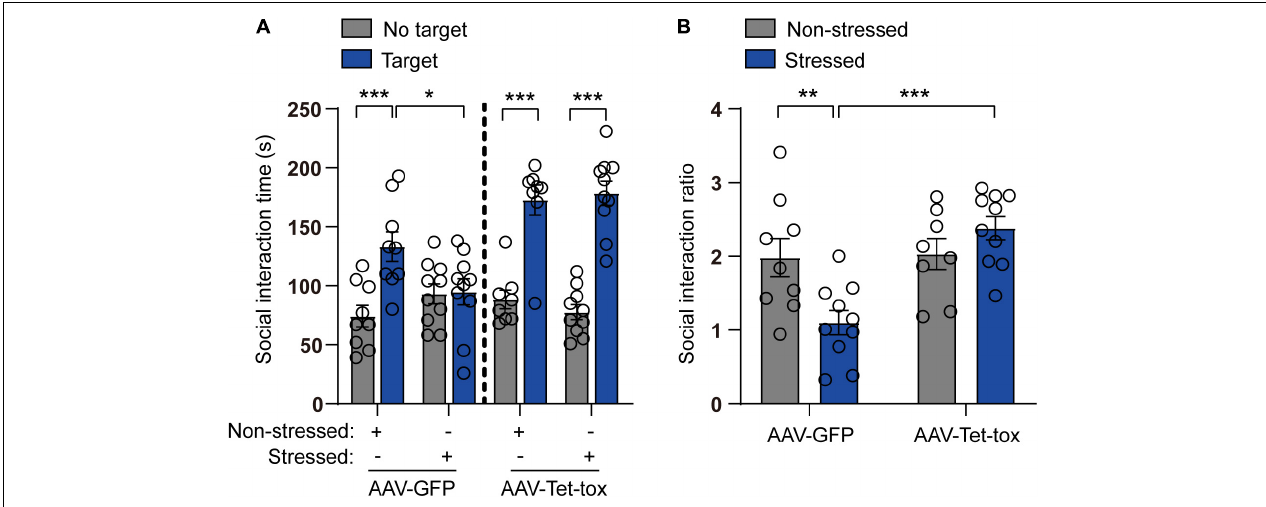
FIGURE 5 | Effect of ZI silencing on RSDS-induced social avoidance. (A) Social interaction time of mice was examined after RSDS training. In the AAV-GFP group, the non-stressed mice showed significant social interaction when the target mice were present, while the stressed mice showed less social interaction; in the AAV-Tet-tox group, both the non-stressed and stressed mice showed significant social interaction when the target mice were present. Two-way ANOVA with bonferroni post hoc test was used to compare the social interaction time between target and no target group. (B) SIR of mice was examined after RSDS training. The SIR of stressed mice was significantly decreased compared to the non-stressed mice in AAV-GFP group, while it was reversed in AAV-Tet-tox group. Two-way ANOVA with bonferroni post hoc test was used to compare the SIR of the non-stressed and stressed mice in AAV-GFP group, and was also used to compare SIR of the stressed mice in AAV-GFP and AAV-Tet-tox group. * p < 0.05, ** p < 0.01, *** p < 0.001.